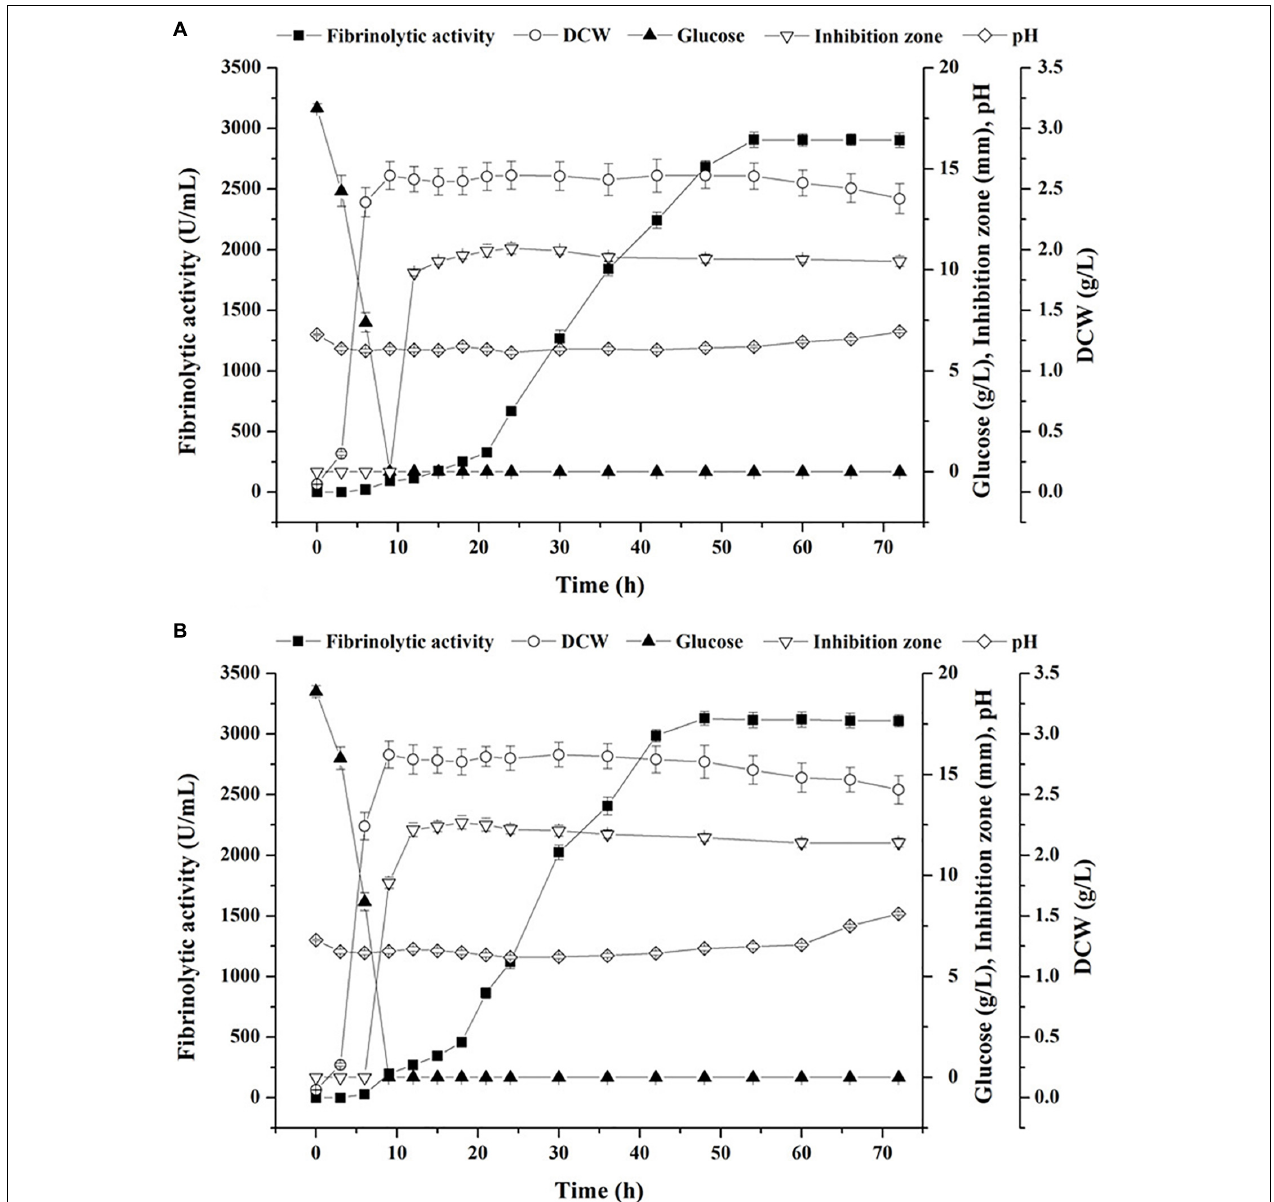
FIGURE 6 | Time courses of batch fermentation of fibrinolytic enzyme with the optimized medium by B. subtilis D21-8 under sterile (A) and non-sterile (B)